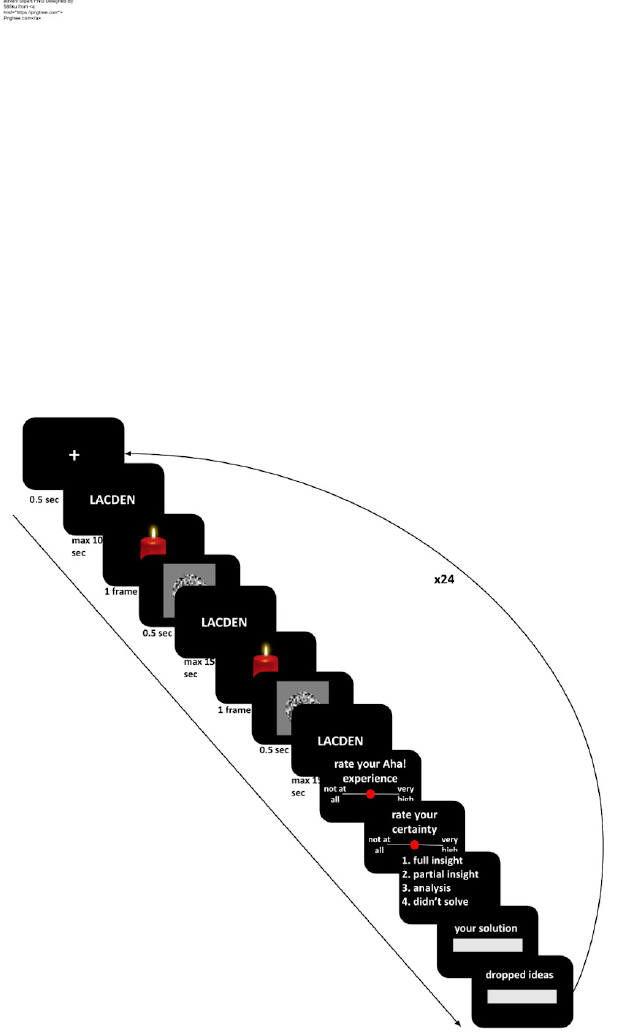
Figure 1. The timeline of the experimental trial (The “candle” image is taken from pngtree.com (Source 2022, accessed on 30 September 2022)).